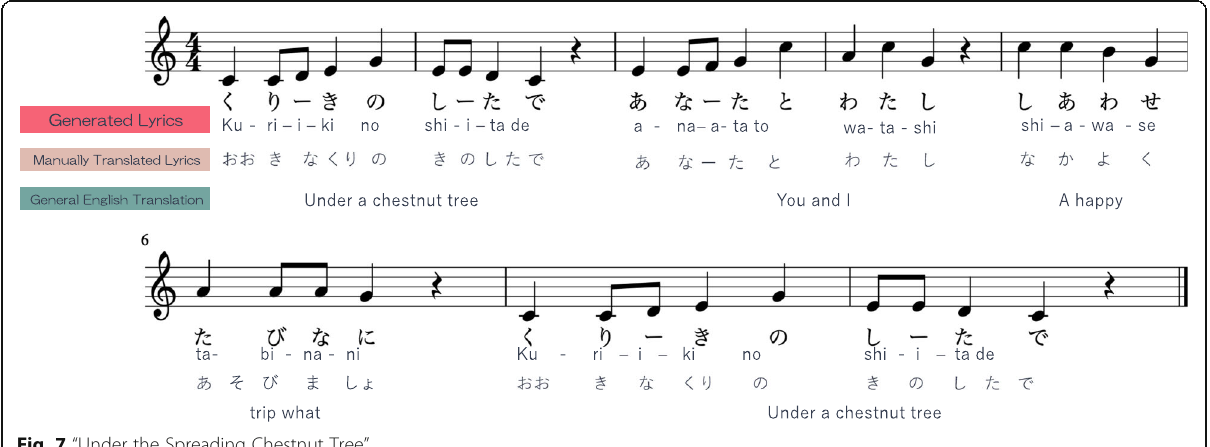
Fig. 7 “ Under the Spreading Chestnut Tree ”